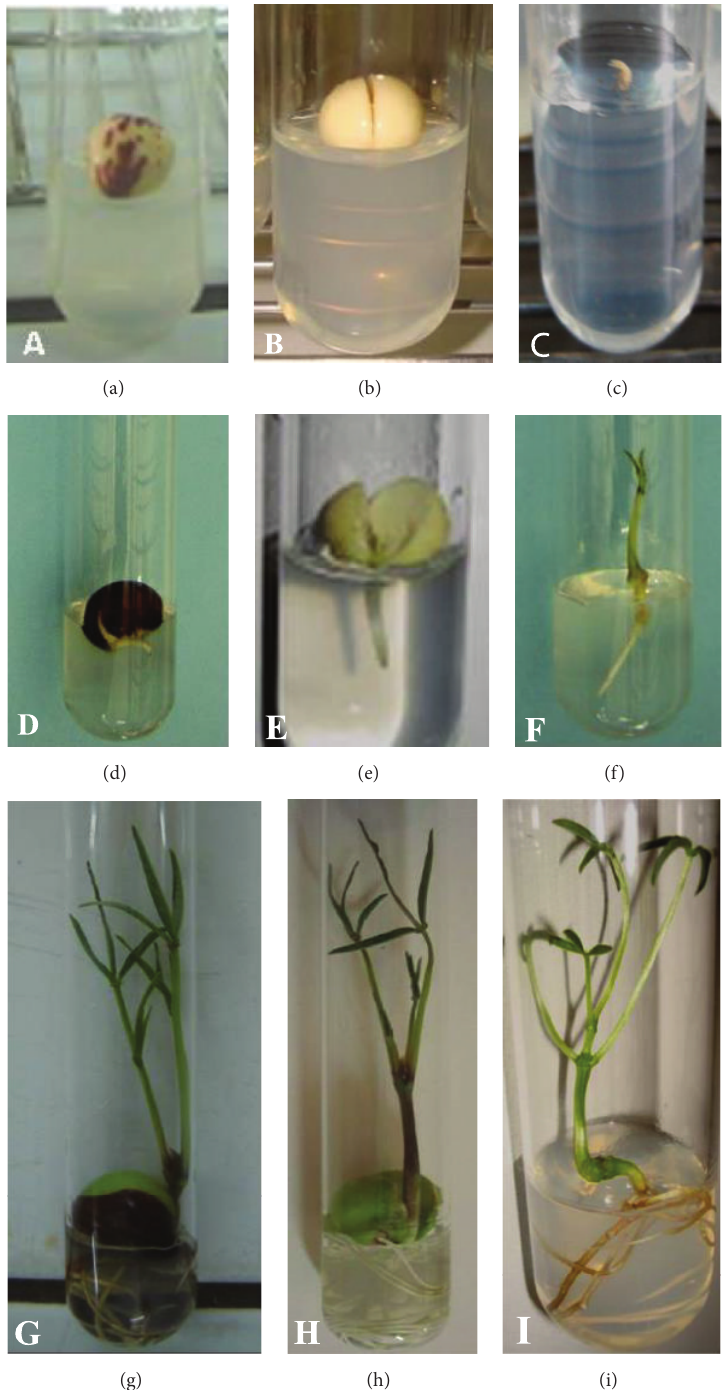
Figure 1: In vitro seeds germination and seedling development of Bambara groundnut . ((a)–(c)) Seeds explants type on MS medium containing 3% sucrose. ((d)–(f)) Cultured seeds type on MS medium containing 3% sucrose after five days of cultivation. ((g)–(i)) Developed seedling derived from seed with seed coat (g); seed without seed coat (h); and embryonic axis (i) after three weeks of incubation on MS medium containing 3%